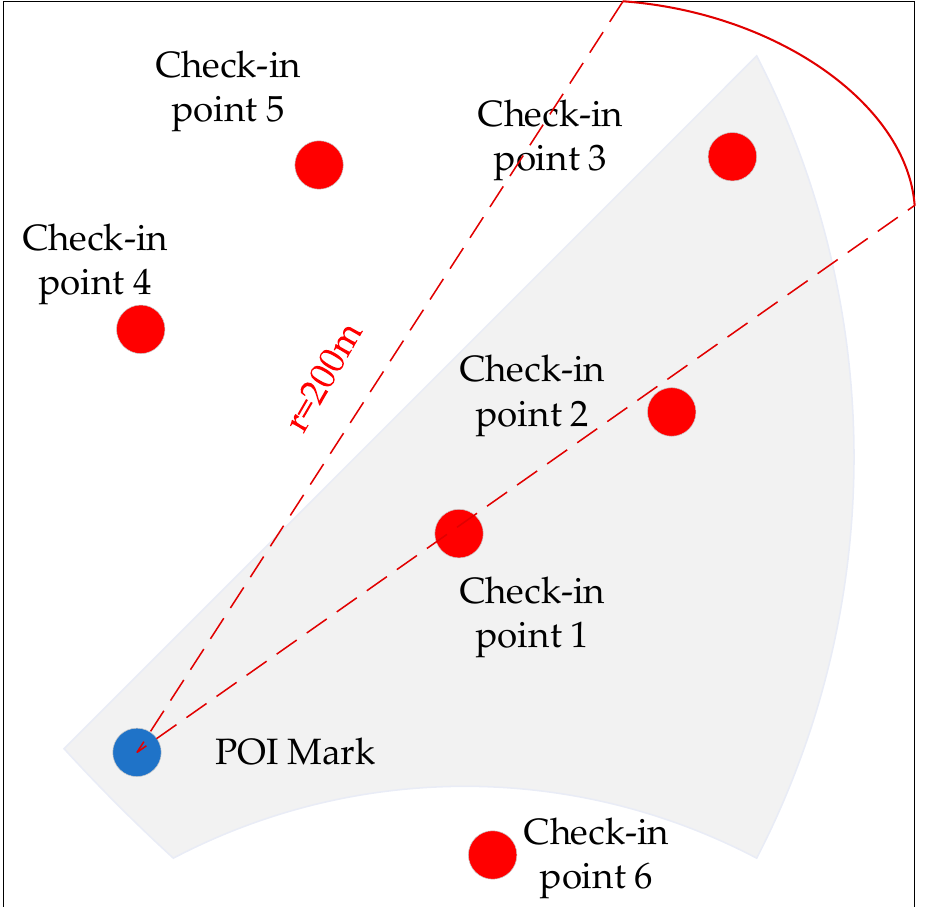
Figure 3. Example of a search range with 200 m radius. Red points denote the check-in points, the blue point represents the point of interest (POI) mark of a facility, and gray area denotes the outline of the facility. When the radius was set to 200 m, all check-in points belonging to the facility (Check-points 1, 2, and 3) were included in the search range.